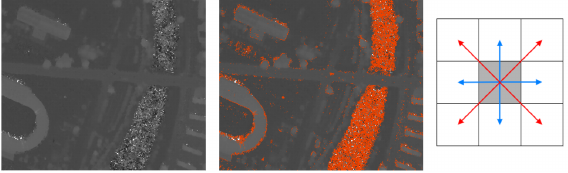
Figure 9. Left: Input noisy DSM. Center: detected disturbed areas. Right: Detection